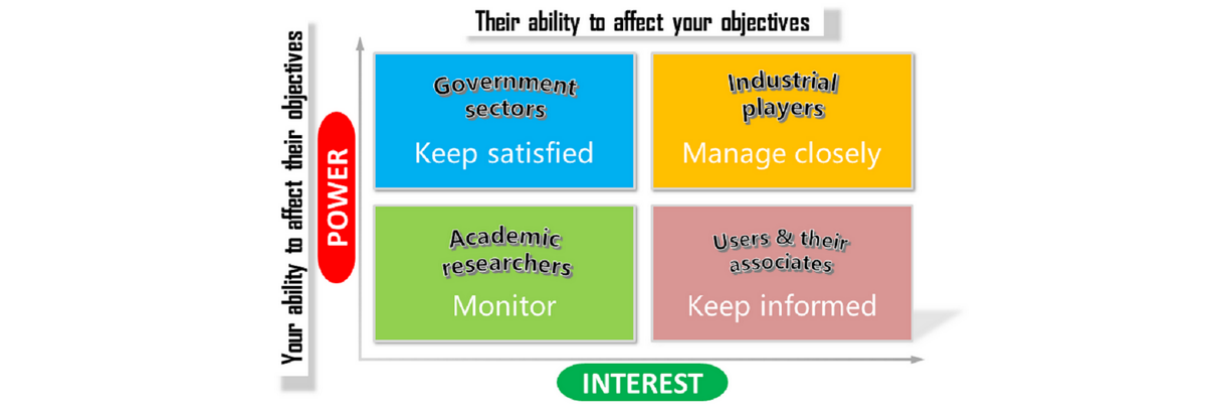
Figure 3. Stakeholder analysis of remote health care (source: adapted from Freeman and Reed